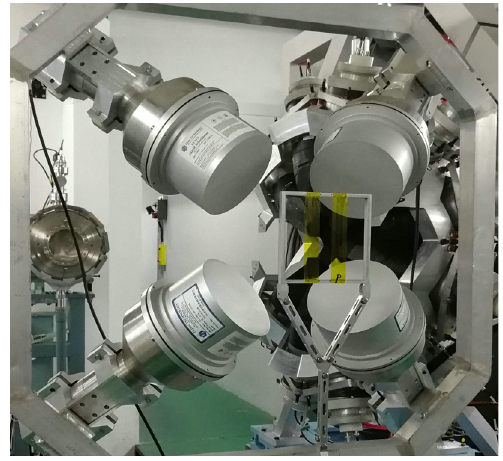
Fig.4 Photo of the C 6 D 6 detector system